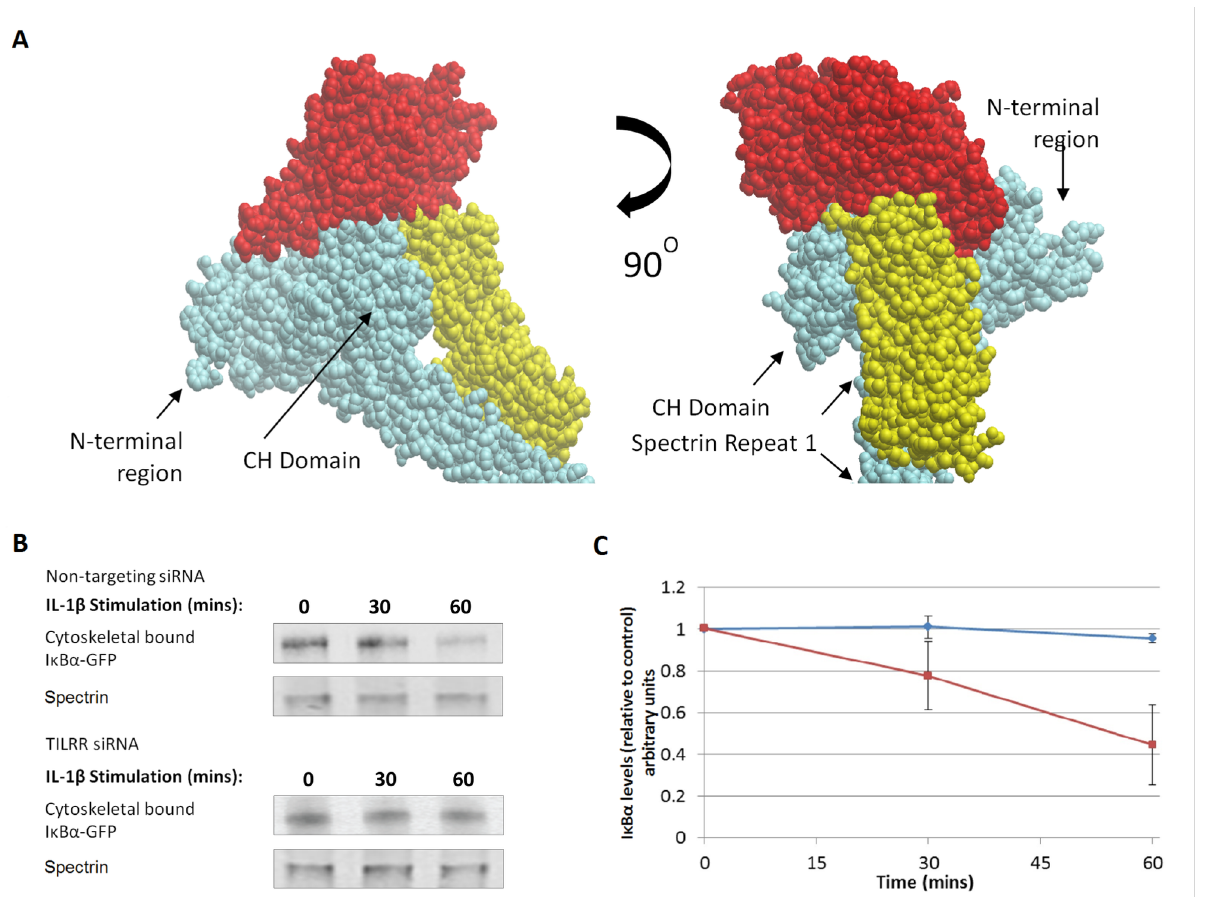
Fig 2. I κ B α interaction with cytoskeletal proteins. A. Space-filling representation of the predicted binding interaction of I κ B α with cytoskeletal proteins spectrin and actin. Two orientations of the complex are shown to illustrate binding interactions between the three molecules. β -spectrin is shown in blue, actin in red and I κ B α in yellow. B. HeLa cells were transfected with I κ B α -EGFP together with a non-targeting siRNA or TILRR siRNA. Cell lysates were immunoprecipitated with an anti-spectrin antibody, and levels of spectrin and of spectrin-associated I κ B α determined by immunoblotting, as described in material and methods. C. Quantitation of spectrin associated I κ B α -EGFP from western blots of cells transfected with random siRNA (control) or TILRR siRNA, and stimulated with IL-1 β (1nM) over time, as in B. Data are presented as fraction of levels in un-stimulated samples (t = 0) and expressed relative to loading control (Mean ± SEM, n = 5, p < 0.05 at 60